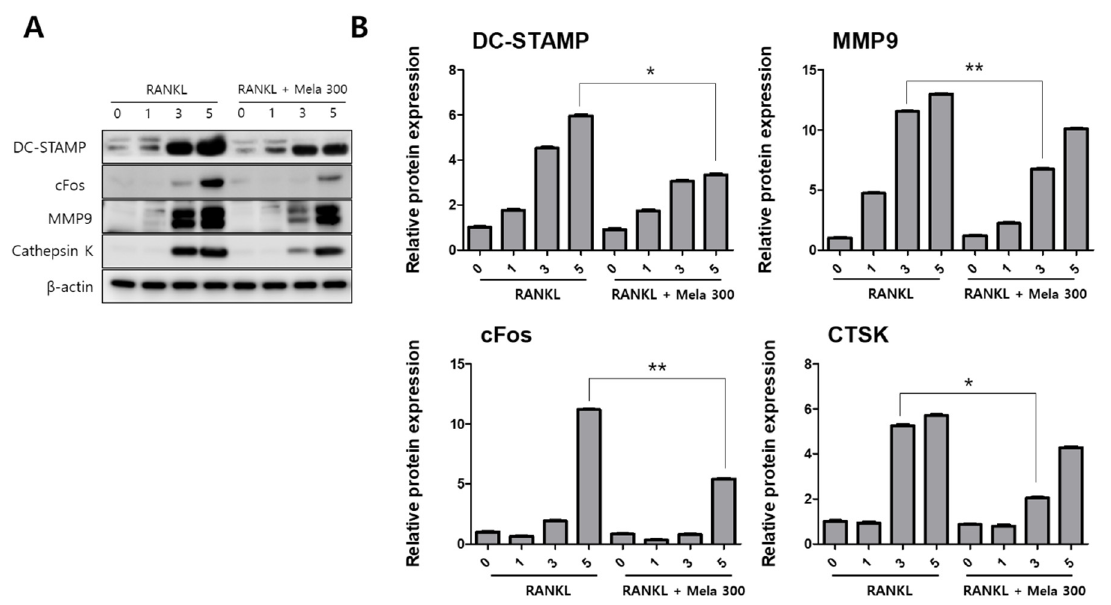
Figure 4. Suppression of the terminal stage and cell-cell fusion markers in osteoclast differentiation in RAW264.7 cells following RANKL and RANKL + melatonin treatment for 1, 3, and 5 days. ( A ) Expression of osteoclastogenesis-related proteins according to western blotting. ( B ) Protein expres- sion graphs of proteins displayed in 4A. The expression data were normalized using β -actin. Values represent the means of three independent experiments ± SDs . RANKL alone treatment and RANKL + melatonin combination treatment were verified using a paired sample t-test (* p < 0.05, ** p <0.01).